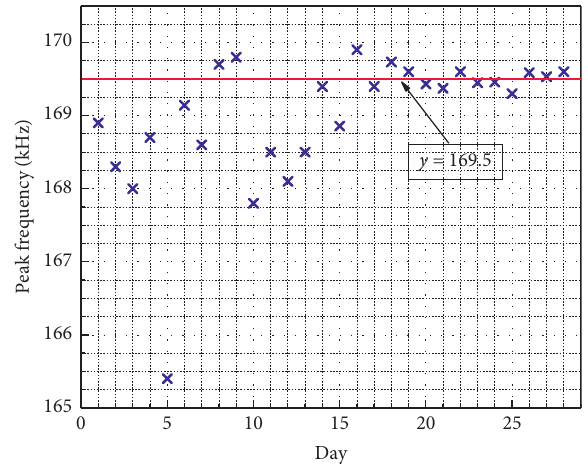
Figure 7: The frequency at the energy peak